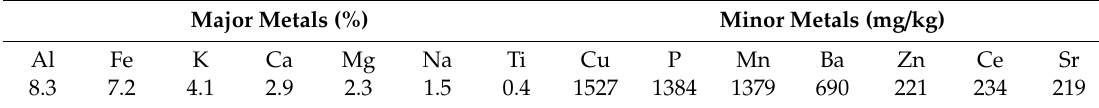
Table 2. Chemical composition of main metals in the ore tailing.